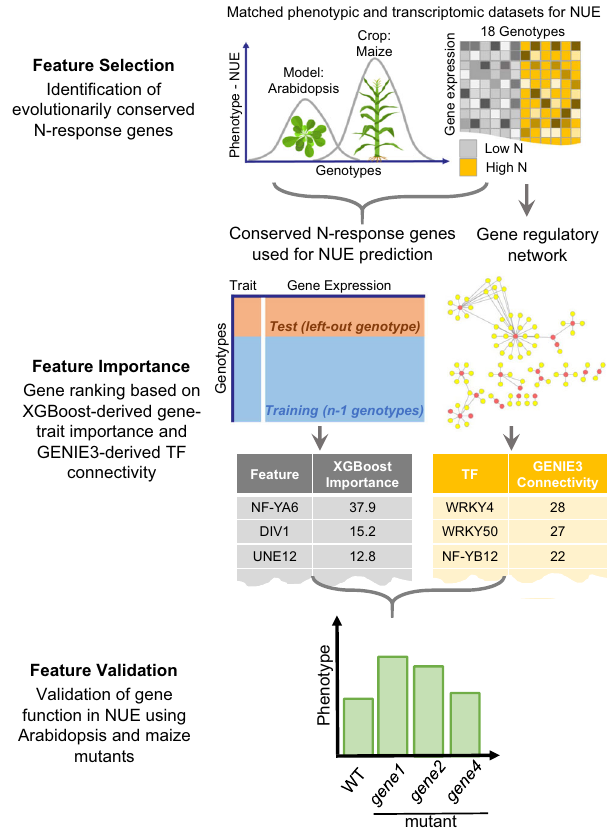
Fig. 1 Evolutionarily informed machine learning approach enhances the predictive power of gene-to-phenotype relationships. Step 1 feature selection: Phenotypic and transcriptomic data of N-responses were generated from Arabidopsis (lab-grown) and maize ( fi eld-grown) under low-N vs. high-N conditions. The expression levels of N-response differentially expressed genes (N-DEGs) conserved in both species were identi fi ed via “ leave-out-one ” approach (Fig. 4) and used as gene features in the machine learning methods in Step 2. This biologically principled approach to reduce the feature dimensions ultimately improved the model performance (Table 1). Step 2 feature importance: We ranked the genes based on (i) the XGBoost-derived feature importance score (left) and (ii) the TF connectivity in a GENIE3 regulatory network (right) constructed from the N-response TFs (Step 1) as regulators and the XGBoost important features as targets. Step 3 feature validation: We validated the role of NUE for eight TFs in planta using Arabidopsis and maize loss-of-function (Supplementary Fig. 2). Using linear models, we identi fi ed N-response differentially expressed genes (N-DEGs) in parallel for maize and Arabidopsis, and retained the N-DEGs conserved both within and across species as gene features used in machine learning. Step 2 feature importance. We selectively used the expression levels of these evolutionarily conserved N-DEGs, as a gradient boosting-based method XGBoost 15 predictive models.